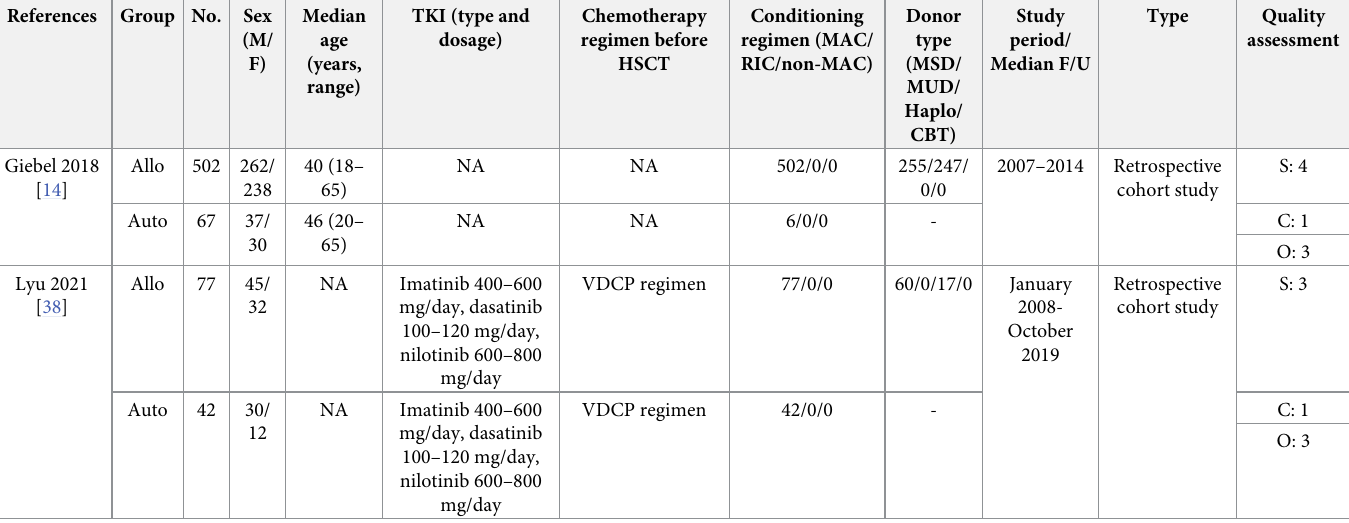
Abbreviations: Allo allogeneic hematopoietic stem cell transplantation, Auto autologous hematopoietic stem cell transplantation, C compatibility, CBT cord blood transplantation, CMT chemotherapy, F female, GRAAPH Group for Research on Adult Acute Lymphoblastic Leukemia Philadelphia positive, Haplo